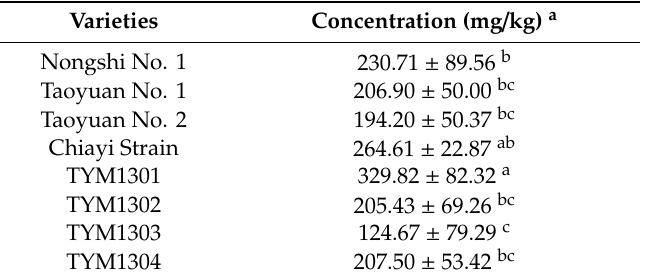
Table 3. Comparisons of the total volatile compounds in eight varieties of Hsian-tsao extracted using SDE.